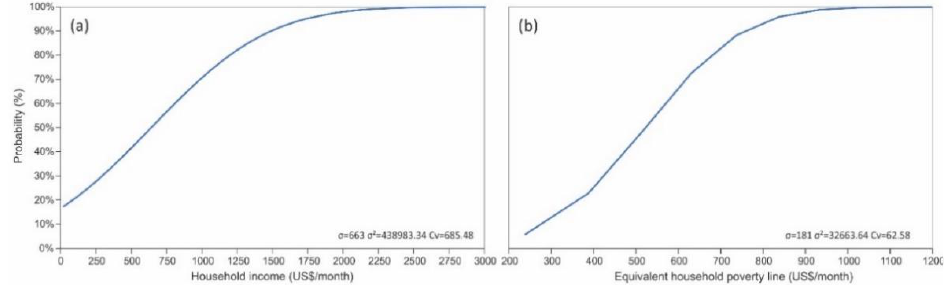
Figure 6. Accumulated distribution of household income ( a ) and equivalent household poverty line ( b ). As for expenditure, bearing in mind rental or mortgage payments, administration fees, and consumption in electricity, gas, water, and Internet or telephone, it can be seen that both in winter and summer, there is a 50% probability that families spend over US$120 in summer and US$127 in winter (see Figure 7). Regarding consumption in elec- tricity and gas, the consumption levels do not show great differences, with the probability of consuming more than US$38.8 in summer being 75%, and 80% in winter. It is important to highlight that, although consumption levels are not high, their relationship compared to the household income represents an important percentage, over 10% in 57.5% of the households in winter. Meanwhile, it is necessary to indicate that not all households in- crease their expenditure on electricity and gas in winter, 30% either maintain or reduce them, which indicates that perhaps other expenditures associated to other energies (i.e., firewood), which have not been collected due to their difficult quantification, are gener- ated.